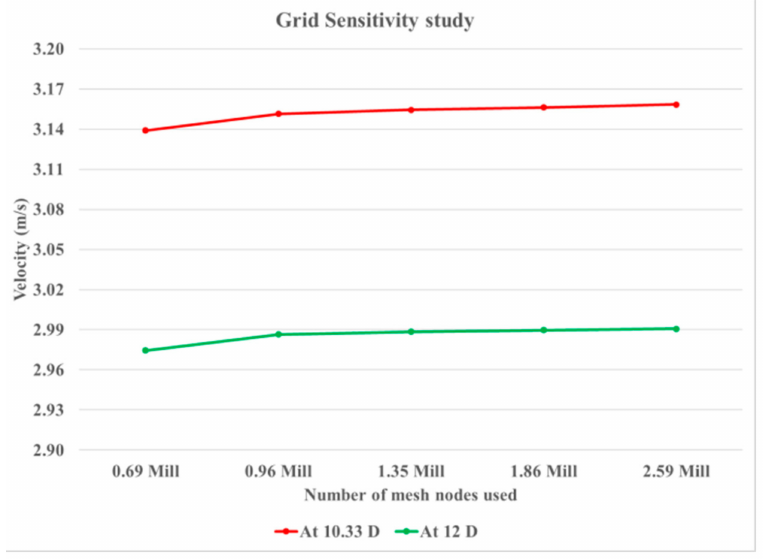
Figure 7. Grid sensitivity study performed for impinging jet domain.